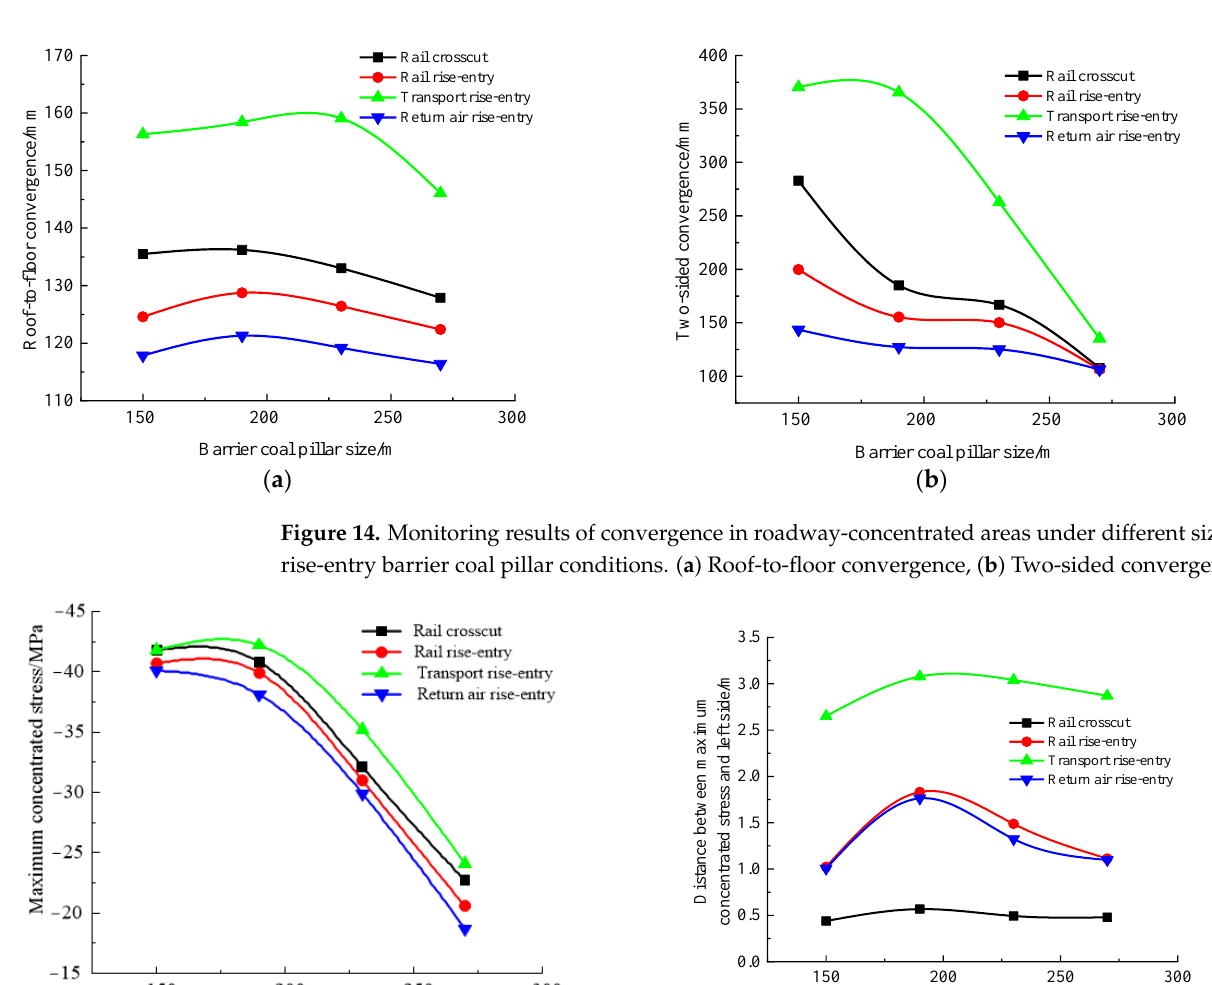
( b ) Figure 13. Maximum concentrated stress and its location monitoring results under different mining height conditions. ( a ) Maximum concentrated stress, ( b ) Position of maximum concentrated stress. It can be seen from Figure 13 that the continuous increase of mining height, − 706-rail crosscut, rail rise-entry, transport rise-entry, and return air rise-entry maximum concen- trated stress showed a trend of increasing first and then decreasing, and when the mining height was 3 m, the changes were significant. The distance between the maximum con- centrated stress and the left side of the roadway decreased first and then increased, and obviously changed when the mining height was 3 m. 4.5. Influence Law of Rise-Entry Barrier Coal Pillar Size